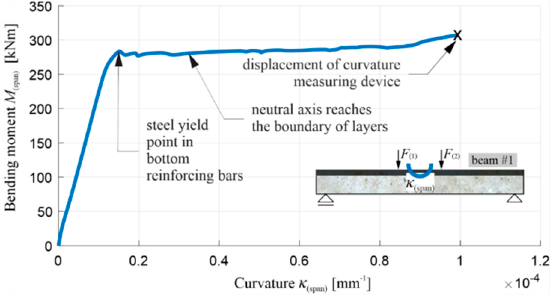
Figure 23. Diagram of the bending moment in the function of the curvature at the middle of the span for beam #1.